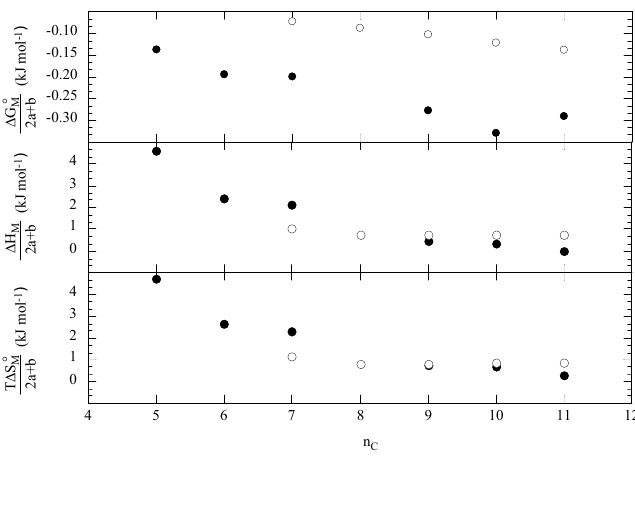
Figure 13. Standard free energy, enthalpy and entropy for the formation of copolymer+surfactant micellar aggregates, normalized for (2a+b), as functions of the number of carbon atoms in the sodium alkanoates alkyl chain. ● , L64; ○ , F68. Data are from Ref.